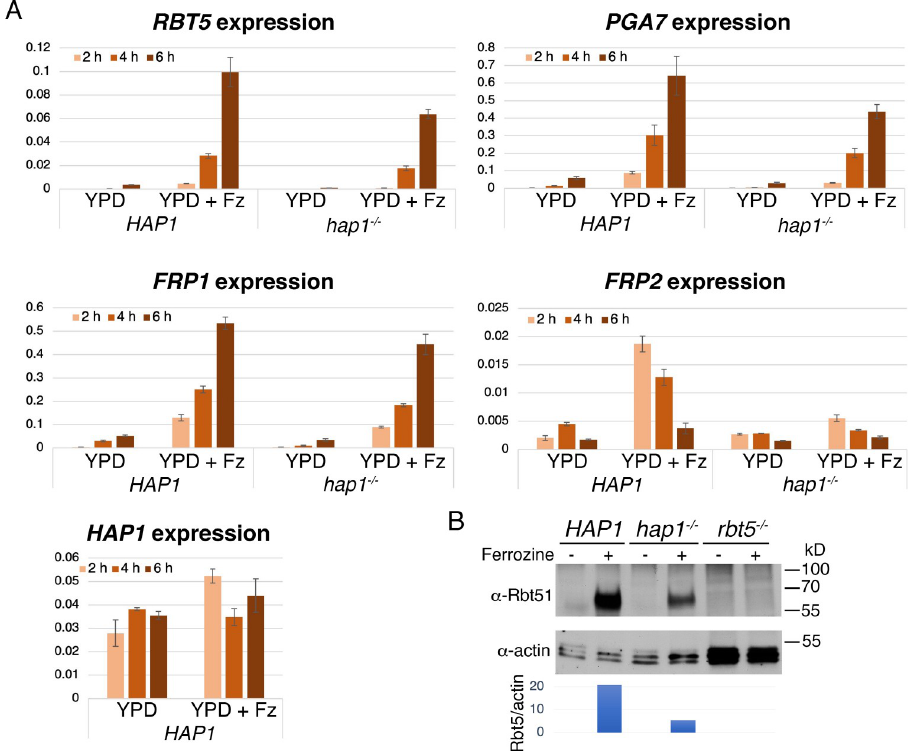
Fig 7. Role of Hap1 in iron starvation-induced expression of heme uptake genes. (A) hap1 -/- mutant (KC1408) and reintegrant (KC1407) log phase cultures were kept in YPD or shifted to YPD + 1 mM ferrozine (YPD + Fz) and aliquots were taken after 2, 4 and 6 h. Expression of the indicated genes was quantitated by RT-PCR and normalized to actin. The values are averages of three independent cultures, with error bars indicating standard deviations. (B) hap1 -/- mutant and reintegrant strains, as well as an rbt5 -/- strain (KC108), were grown as in A, aliquots were taken after 4 hours and the Rbt5 protein was detected with a polyclonal antibody (top panel). The actin signal was used as internal control (middle panel), and the bottom panel indicates the ratio of Rbt5 to actin